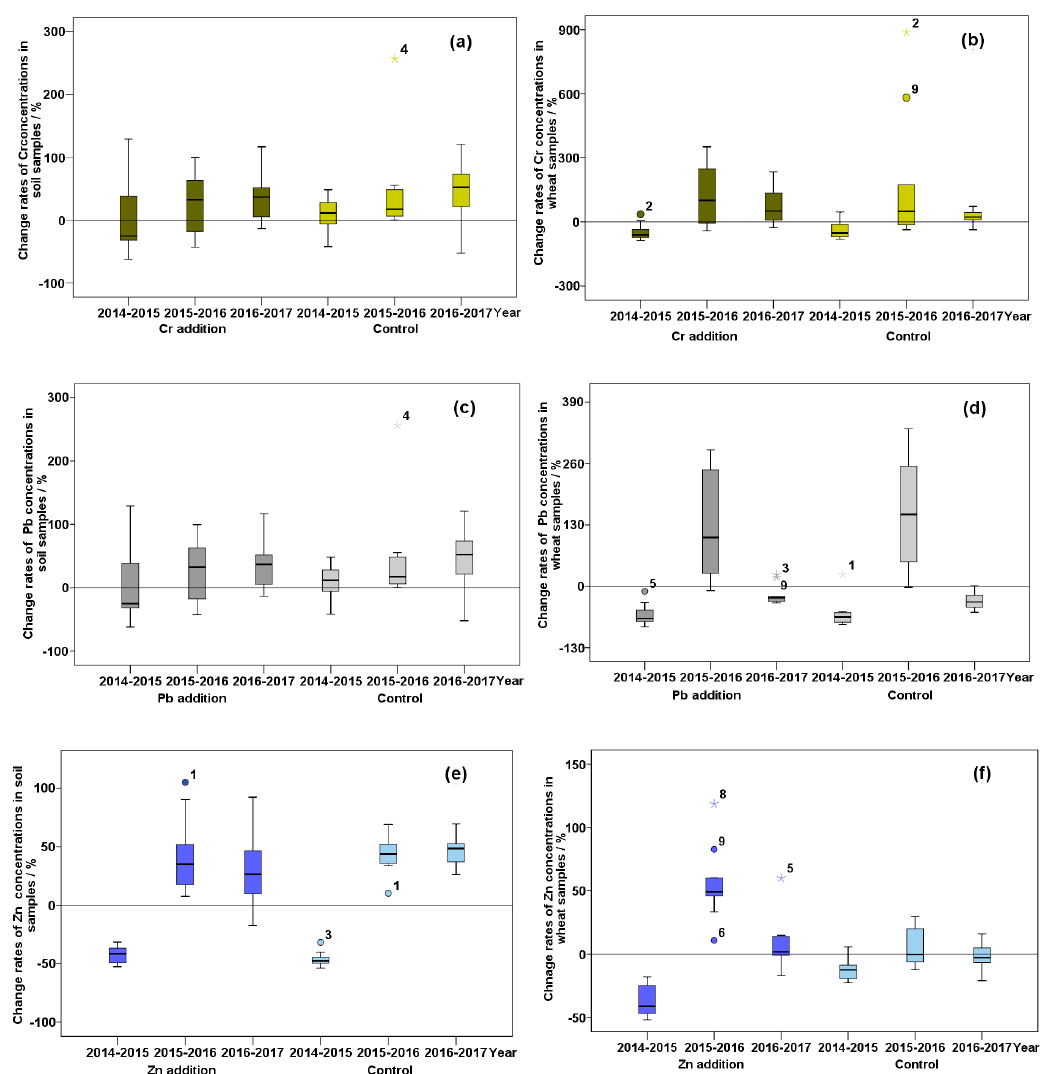
Figure 1. Change rates of Cr, Pb, and Zn concentrations in the soil-wheat system from 2014 to 2015, 2015 to 2016, and 2016 to 2017: ( a ) Cr in soil; ( b ) Cr in wheat; ( c ) Pb in soil; ( d ) Pb in wheat; ( e ) Zn in soil; and ( f ) Zn in wheat. For the addition sites and control site, Cr concentrations are expressed by dark yellow and light yellow, Pb concentrations are expressed by dark gray and light gray, and Zn concentrations are expressed by dark blue and light blue. Circles and asterisks with numbers are samples with outliers.